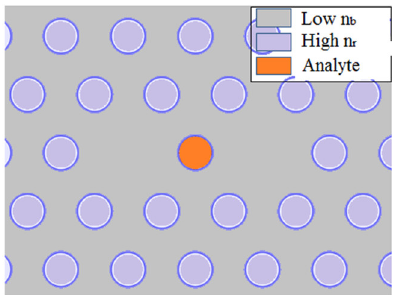
Figure 40. Dual core photonic bandgap fiber sensor; fabricated from a low index (n b ) host material and higher index (n r ) rod inclusions for analyte sensing (Figure courtesy from the reference [35]).